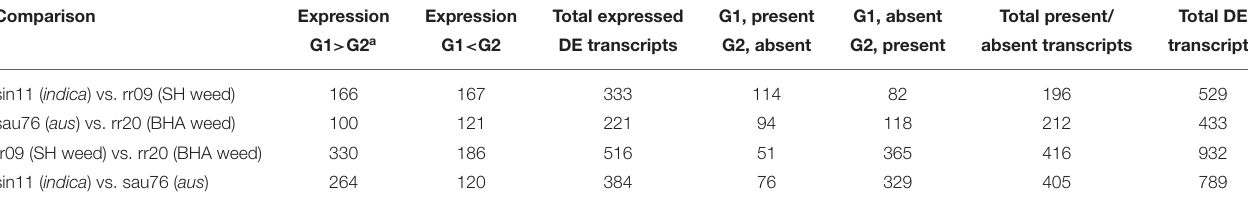
TABLE 3 | Summary of differentially expressed (DE) transcripts for the four RNA-seq comparisons. Comparison